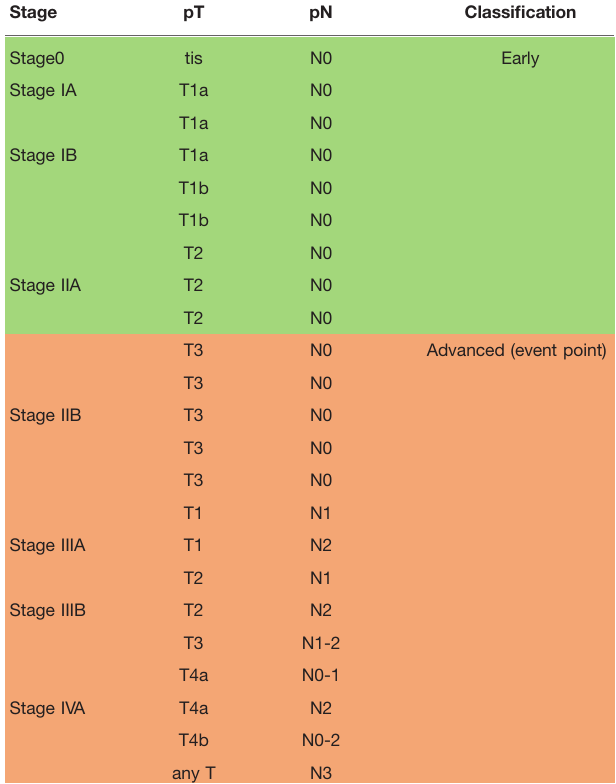
TABLE 1 | Early-advanced ESCC classi fi